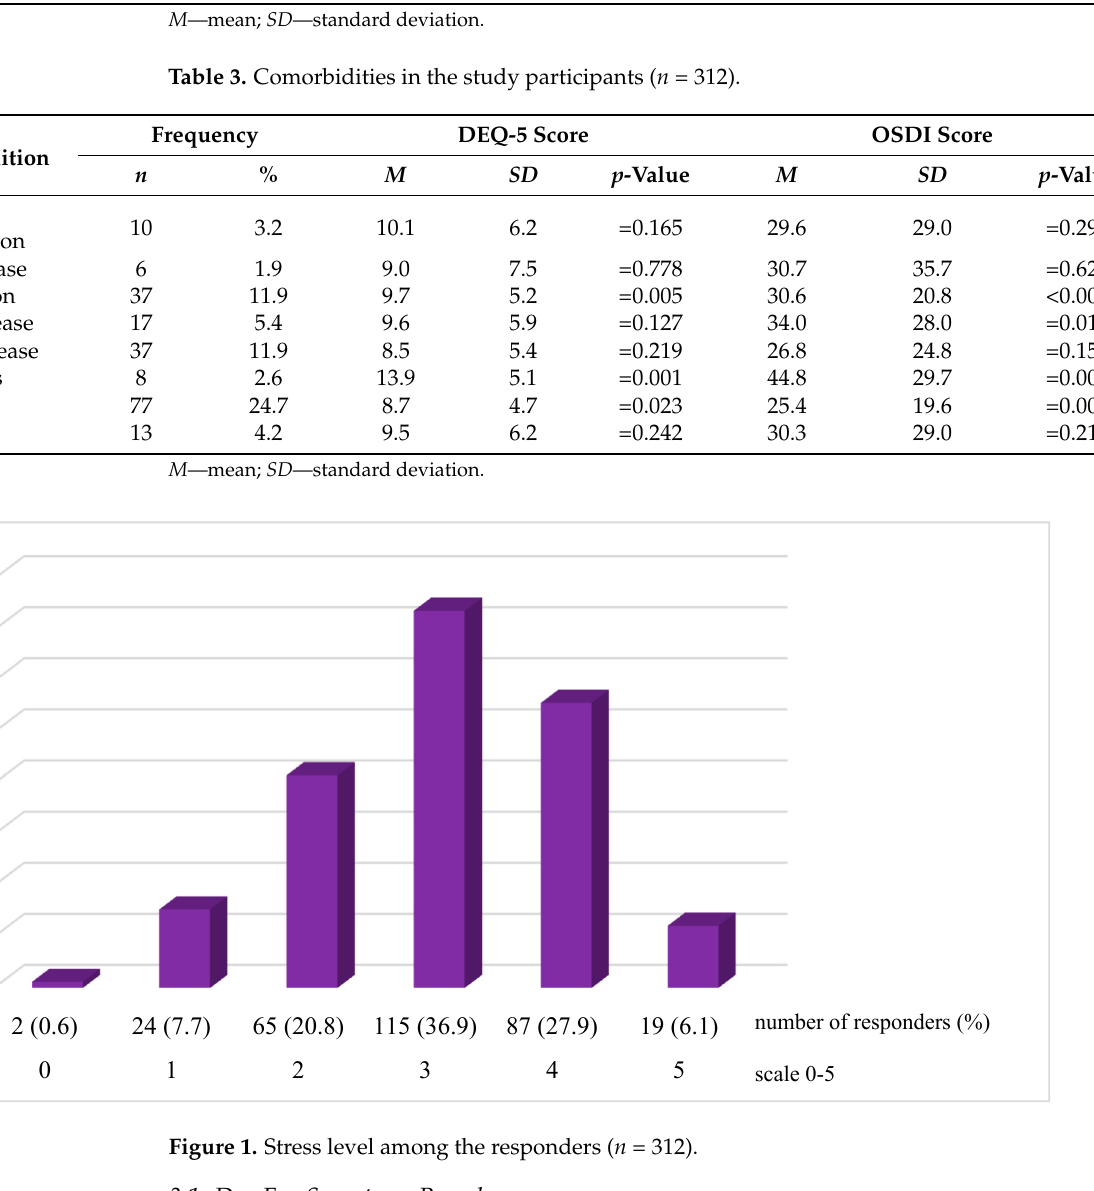
Table 3. Comorbidities in the study participants ( n = 312).